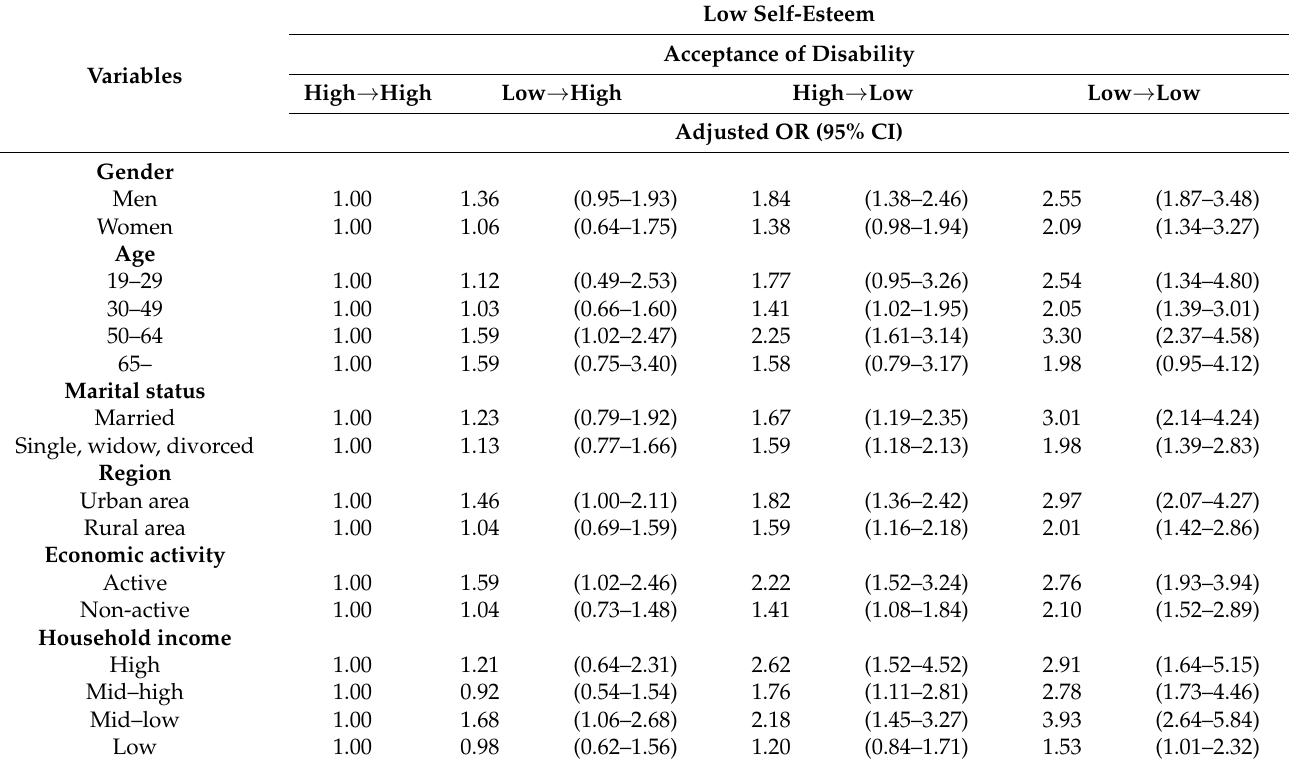
Table 3. Subgroup analysis using the GEE of low self-esteem according to acceptance of